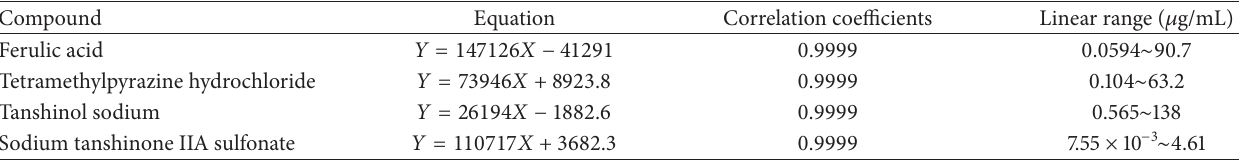
Table 3: The correlation coefficients and linear range of linear regression equations.